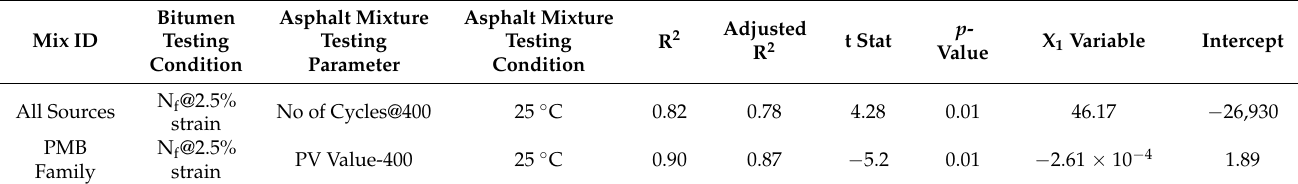
Table 12. Best correlated parameters and testing conditions of bitumen LAS@25 ◦ C with asphalt mixture; Four Point Bending Beam tests at 300 µ strain and 400 µ strain@25 ◦